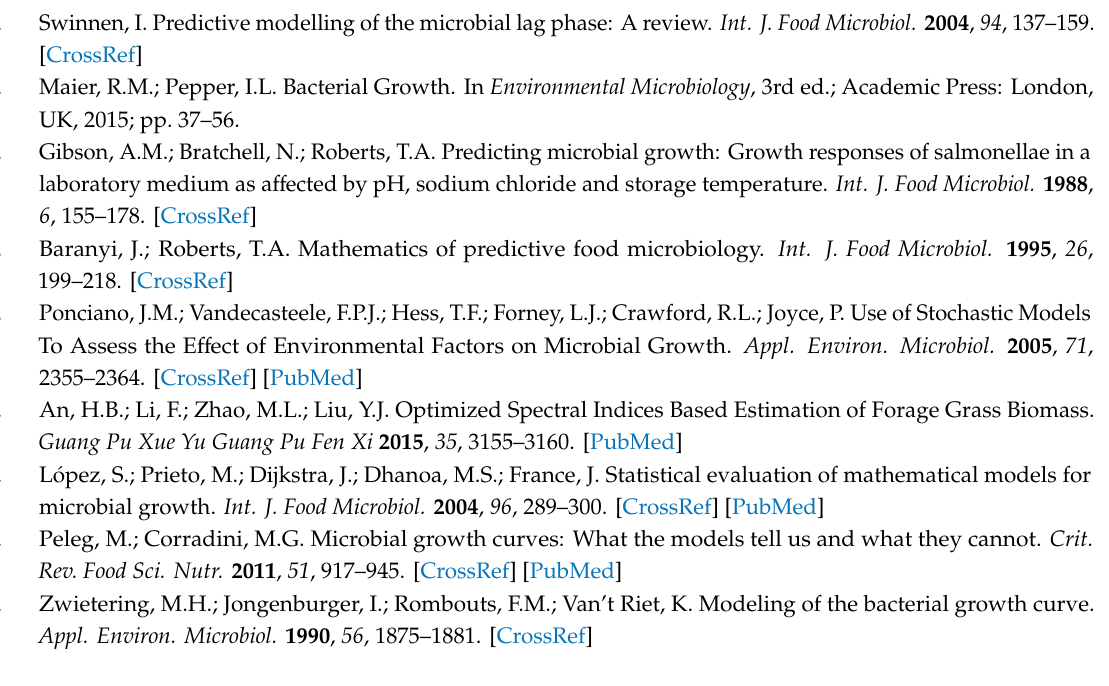
Figure S1: Comparison of DTW and DDTW; Figure S2: Clusters of the growth